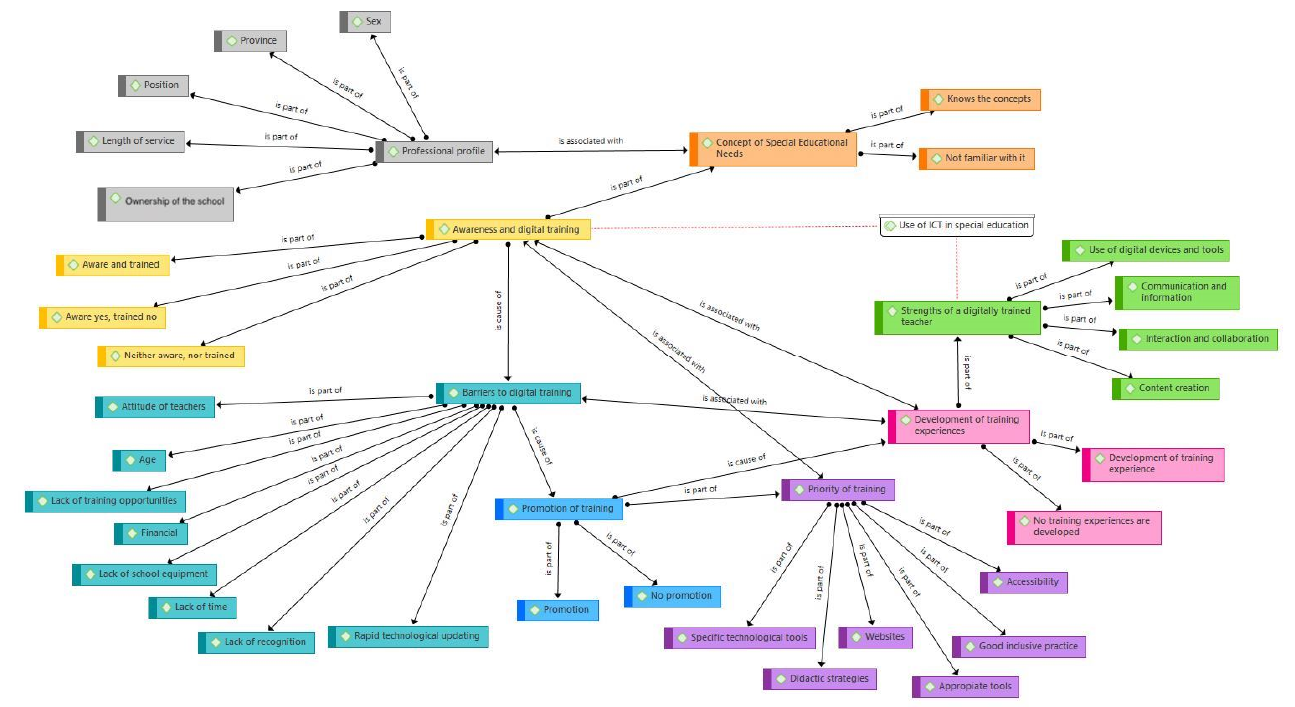
Figure 1. Semantic network of categories and subcategories.